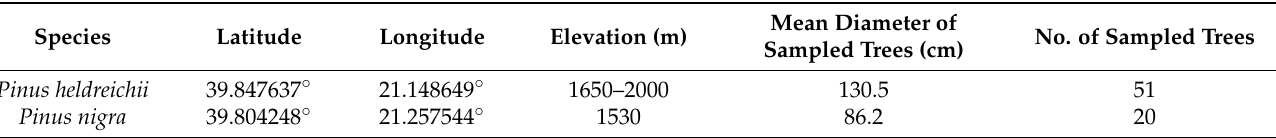
Table 1. General characteristics of the two sites from where cores from living trees were collected for the development of the local reference